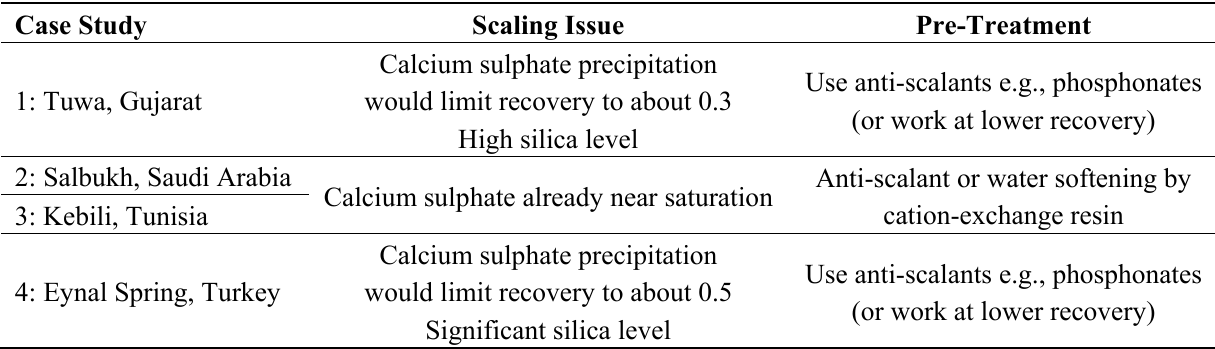
Table 6. Scaling and preventative chemical pre-treatments for the four case studies. Case Study Scaling Issue